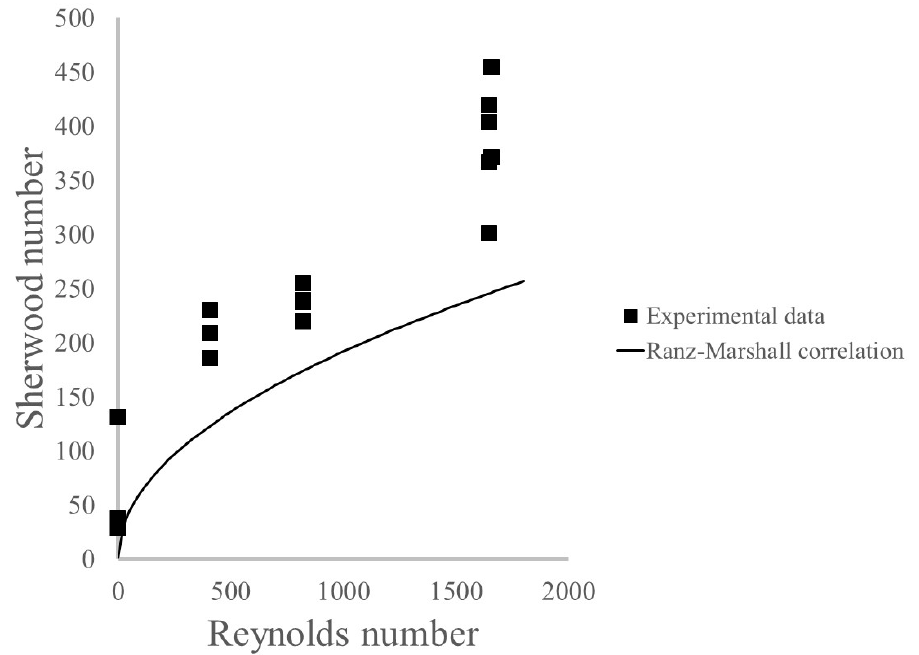
Figure 5. Sherwood number as a function of Reynolds number for USP dissolution apparatus 2.